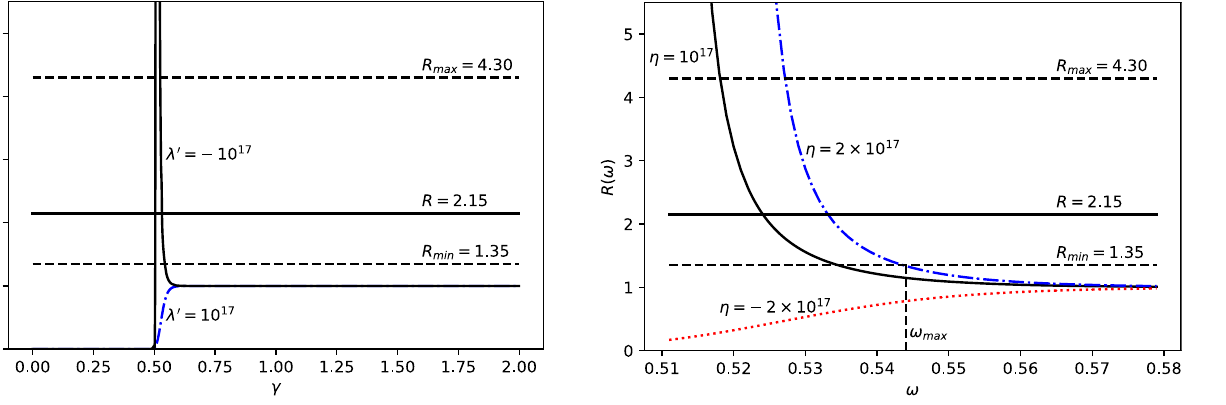
Fig. 6 R vs γ for fixed energy E = E 12 (cid:2) 5 . 9 × 10 − 6 eV. The λ (cid:9) = + 10 17 branch is presented in dash-dot blue and the λ (cid:9) = − 10 17 branch is presented in solid black